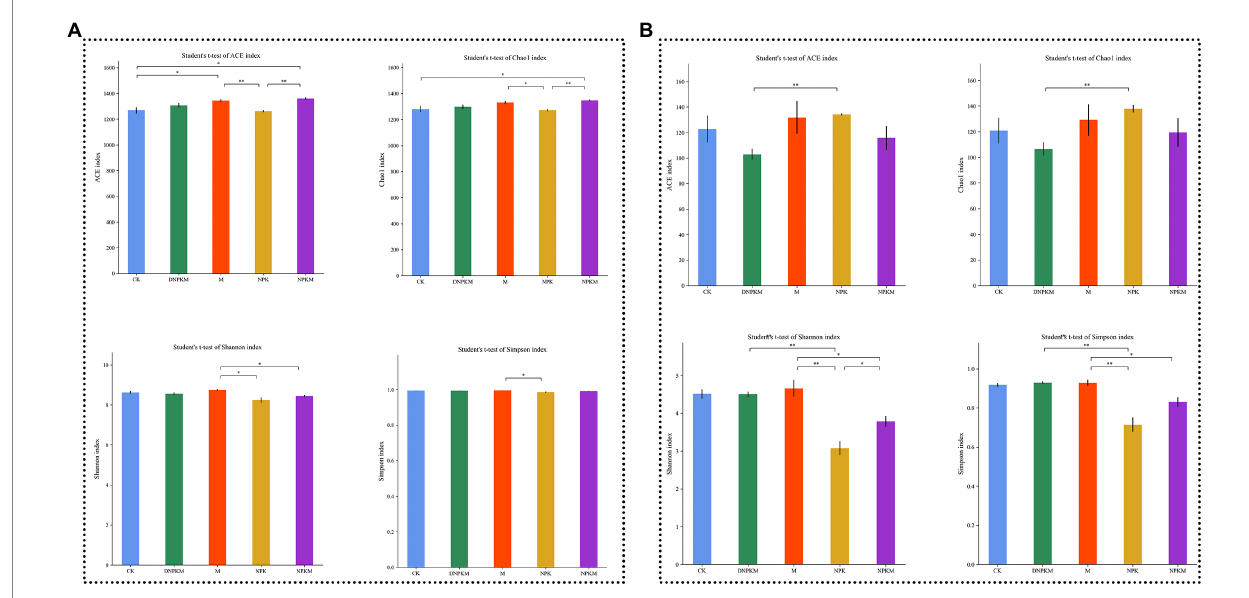
FIGURE 1 Effect of fertilizer strategies on the alpha-diversity index (ACE, Chao1, Shannon, and Simpson) of soil bacterial community (A) and fungal community (B) . * p < 0.05, ** p < 0.01.